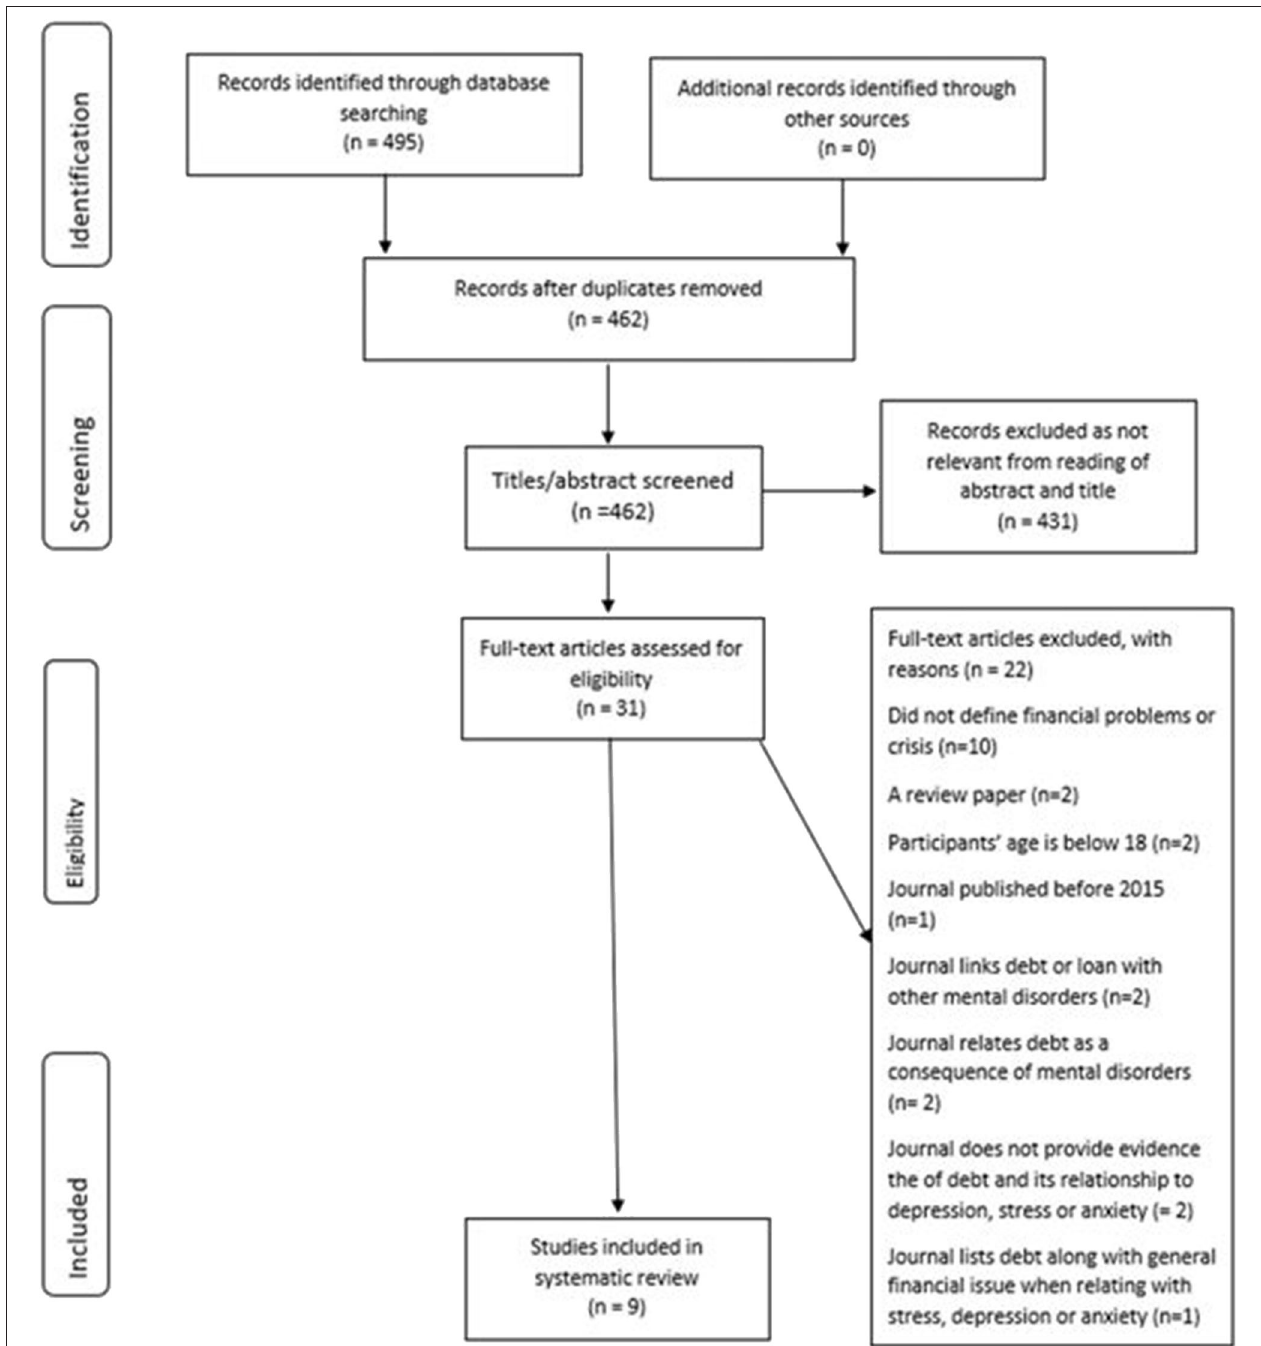
FIGURE 1 | PRISMA flow